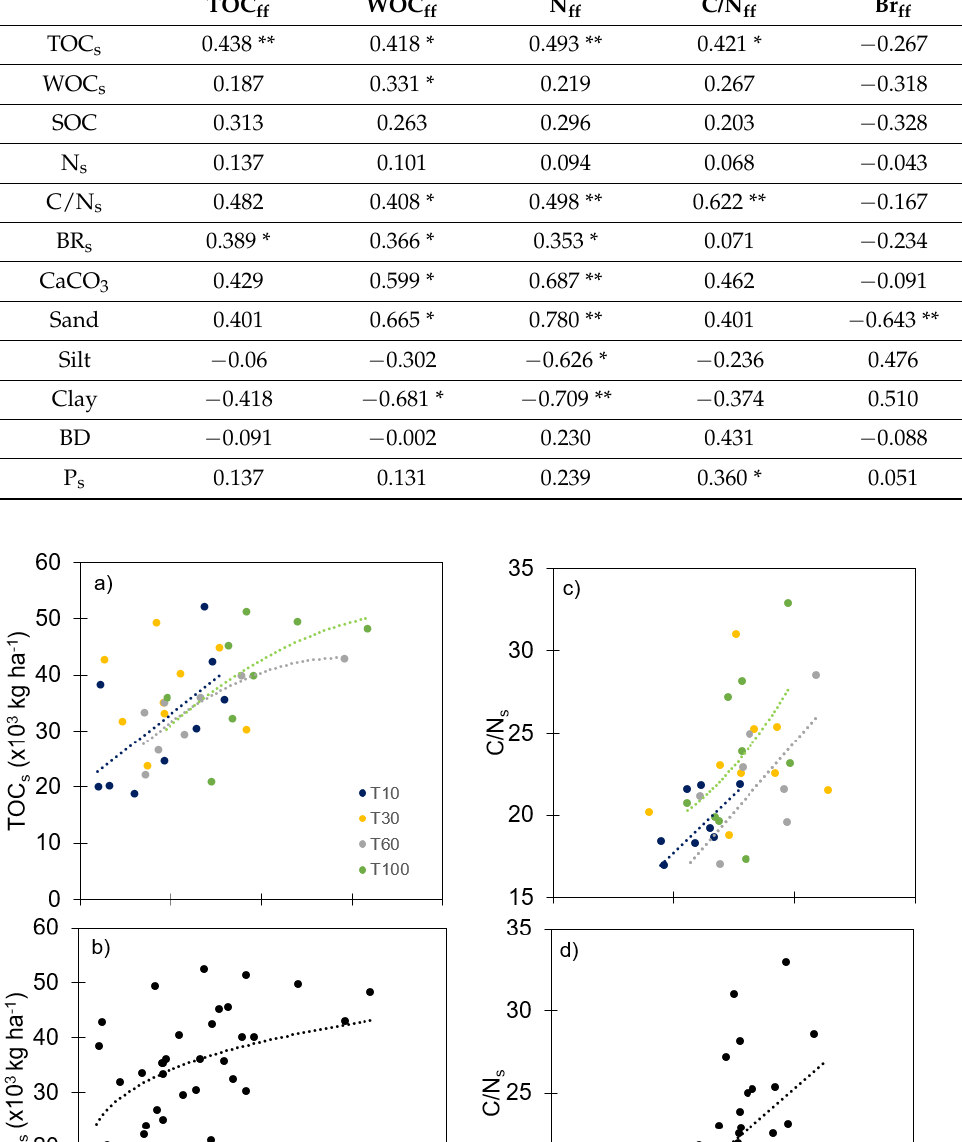
Table 4. Correlation matrix (Spearman correlation coefficients) between the soil (s) and forest floor measurements (ff): TOC: total organic carbon, WOC: dissolved organic carbon, SOC: easy oxidizable organic carbon, N: nitrogen content, C/N: C/N ratio, BR: basal respiration, BD: bulk density, Ps: soil phosphorous content. ** Significant correlation at p -value < 0.01; * significant correlation at p -value